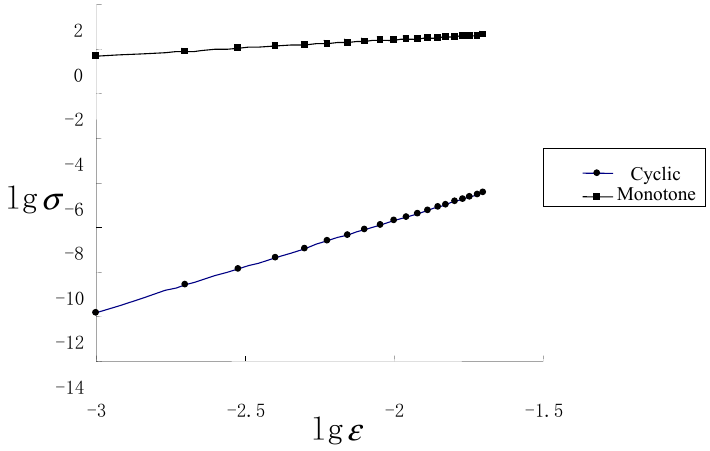
Figure 6. Comparison between cyclic curves and monotone curve.